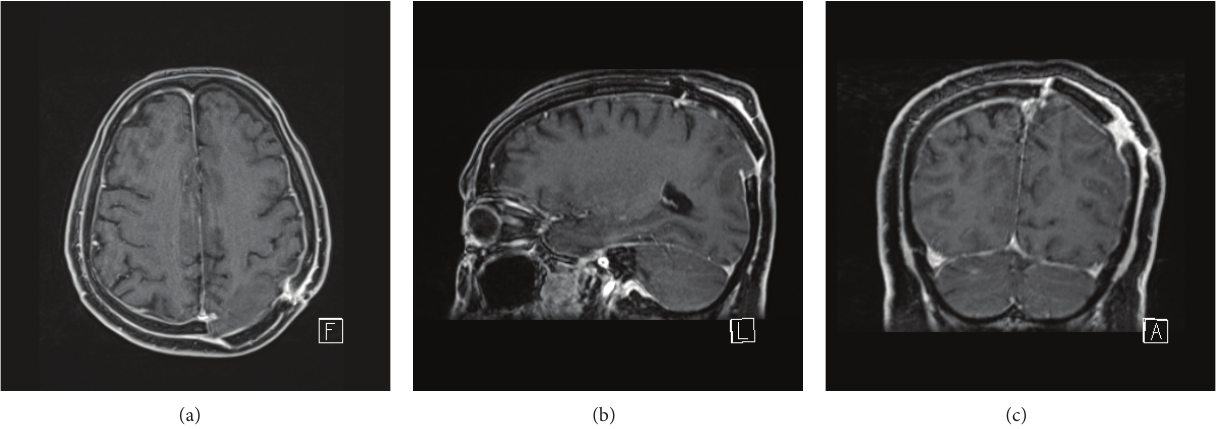
Figure 2: Gd-enhanced, T1-weighted MRI: postoperative axial (a), sagittal (b), and coronal (c) images show the complete excision of the